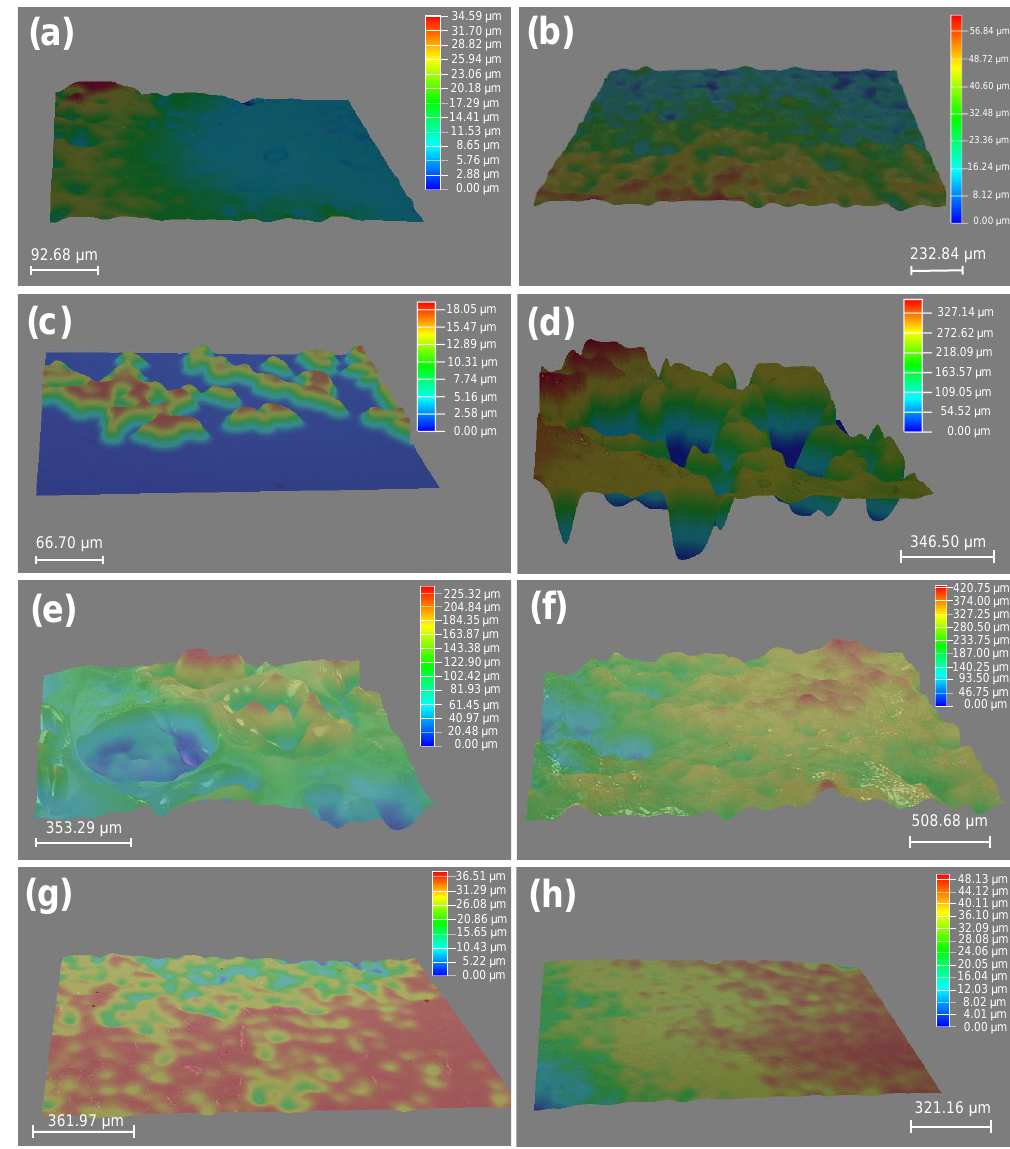
Figure 4. 3D images of surface morphologies of hydrogels obtained by the solvent exchange of organo-gels with equilibrium state in DMSO: ( a ) PAAm; ( b ) PDMA; ( c ) PMA; ( d ) PPA; ( e ) PBnA; ( f ) PPHEA; ( g ) PCBA; ( h ) PTHFA.